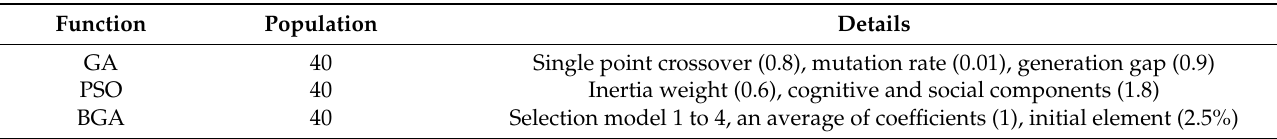
Table 3. Parameters of the algorithm